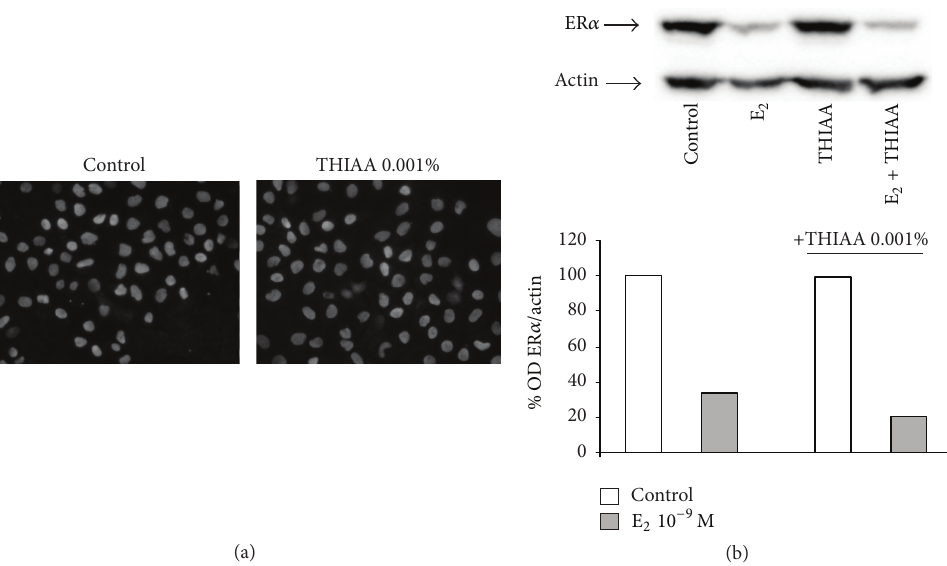
Figure 9: Effect of THIAA on ER 𝛼 protein level in steroid-free culture medium by immunofluorescence (a) and western blot (b). MCF-7 cells were incubated for 24 h in the absence (control) or presence of E 2 at 10 −9 M with or without THIAA at 0.001%. Immunofluorescence, immunoblots, and optical density (OD) analyses of ER 𝛼 refer to an experiment performed independently twice. ODs of ER 𝛼 are normalized by ODs of actin and expressed as percentage of